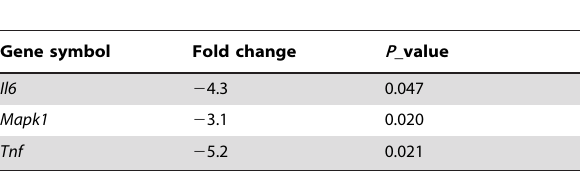
Table 5. Fold change of AcarH vs. DM in gene expression measured by Q-RT-PCR.